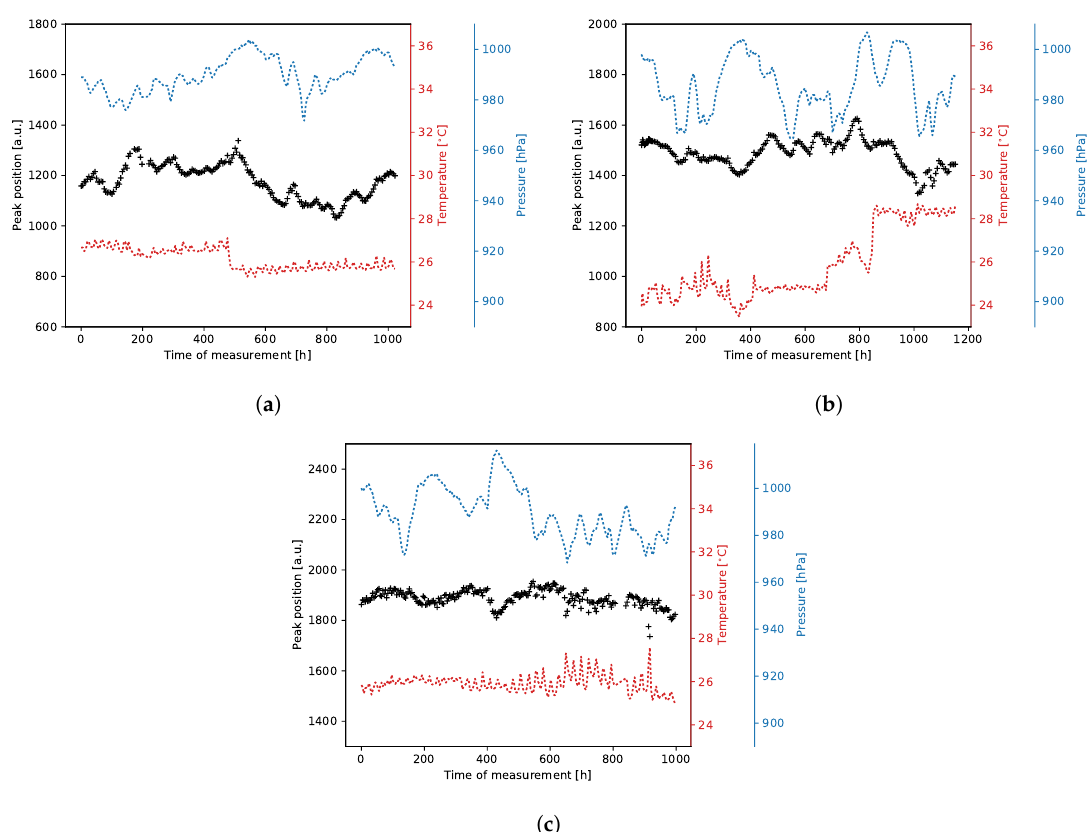
Figure 23. Long-term measurements results. ( a ) GEM detector with 10nm chromium foils ( A 2 ); ( b ) GEM detector with 100nm chromium foils ( C 1 ); ( c ) Standard GEM detector with copper foils ( E